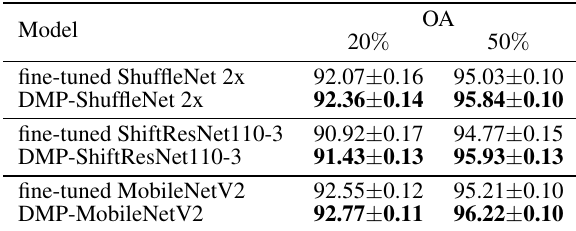
Table 2. Performance improvement of ShuffleNet, ShiftResNet110-3 and MobileNetV2 on Aerial Image data